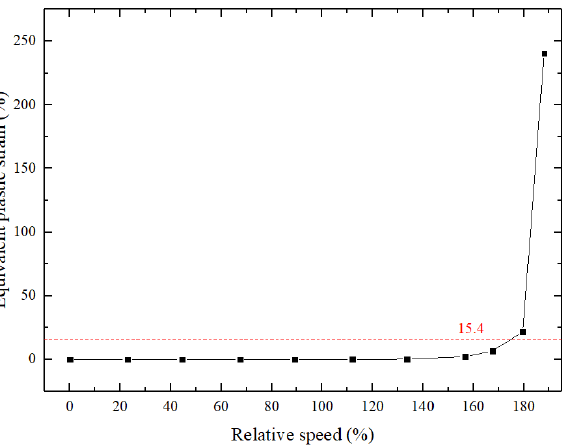
Figure 24. The variation of equivalent plastic strain of the dangerous section of the vortex reducer with rotational speed.